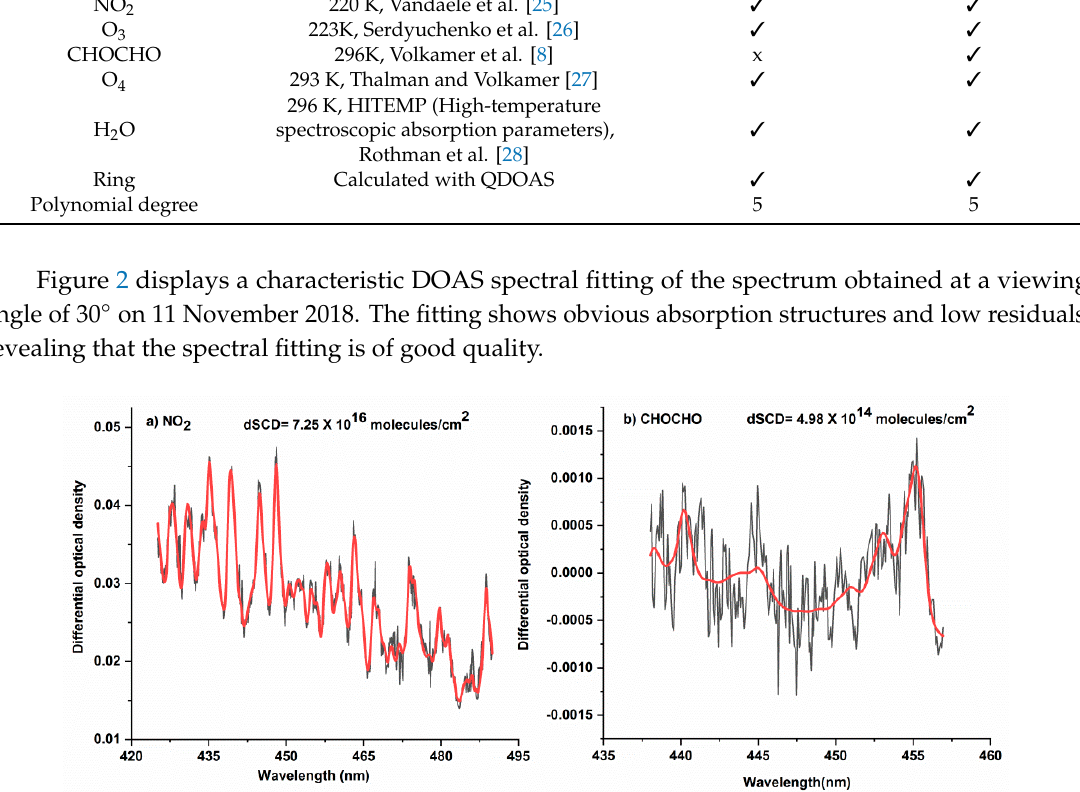
Figure 2. Characteristic DOAS spectral fitting of the spectrum obtained at a viewing angle of 30° on 11 November 2018 for ( a ) NO 2 and ( b ) CHOCHO. Legend: dSCD, differential slant column density. Vertical column densities were generated using an air mass factor (AMF) [29].